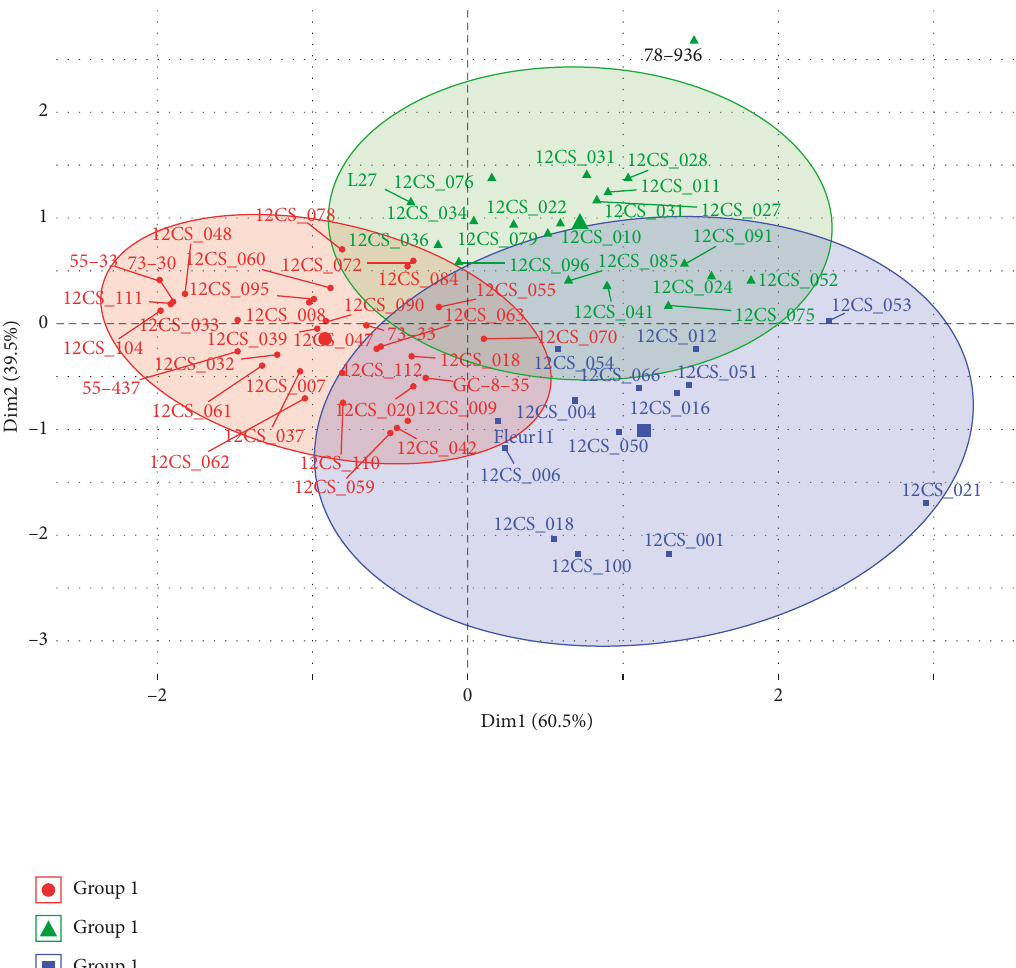
Figure 3: Principal component analysis biplot showing peanut genotypes clustering based on their severity and incidence.